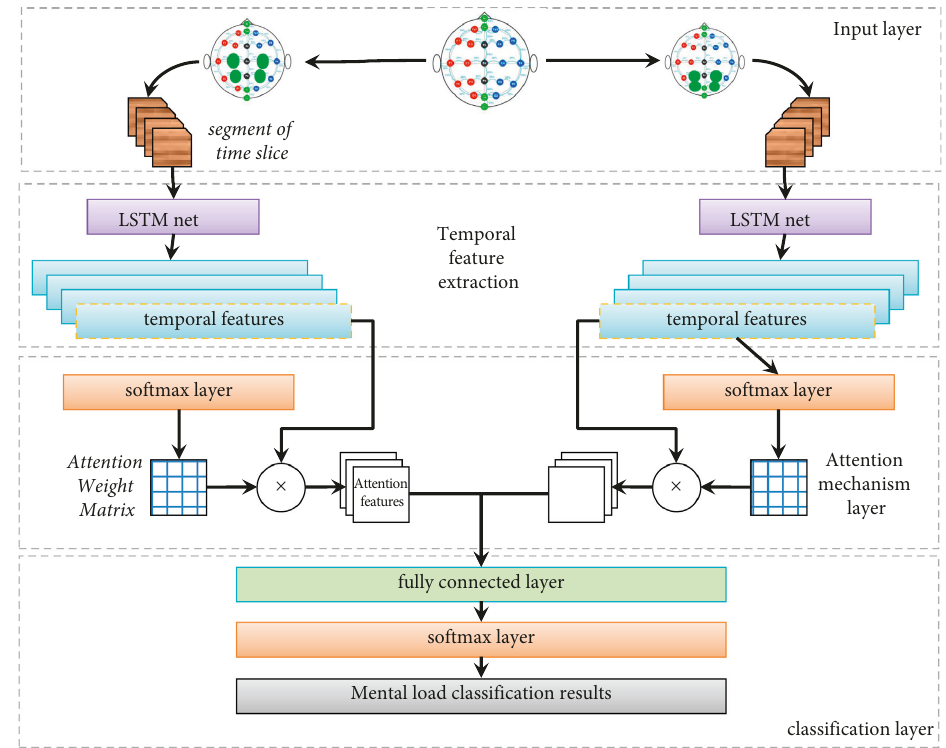
Figure 4: Mental workload evaluation model architecture diagram. Table 1: The sample size of the